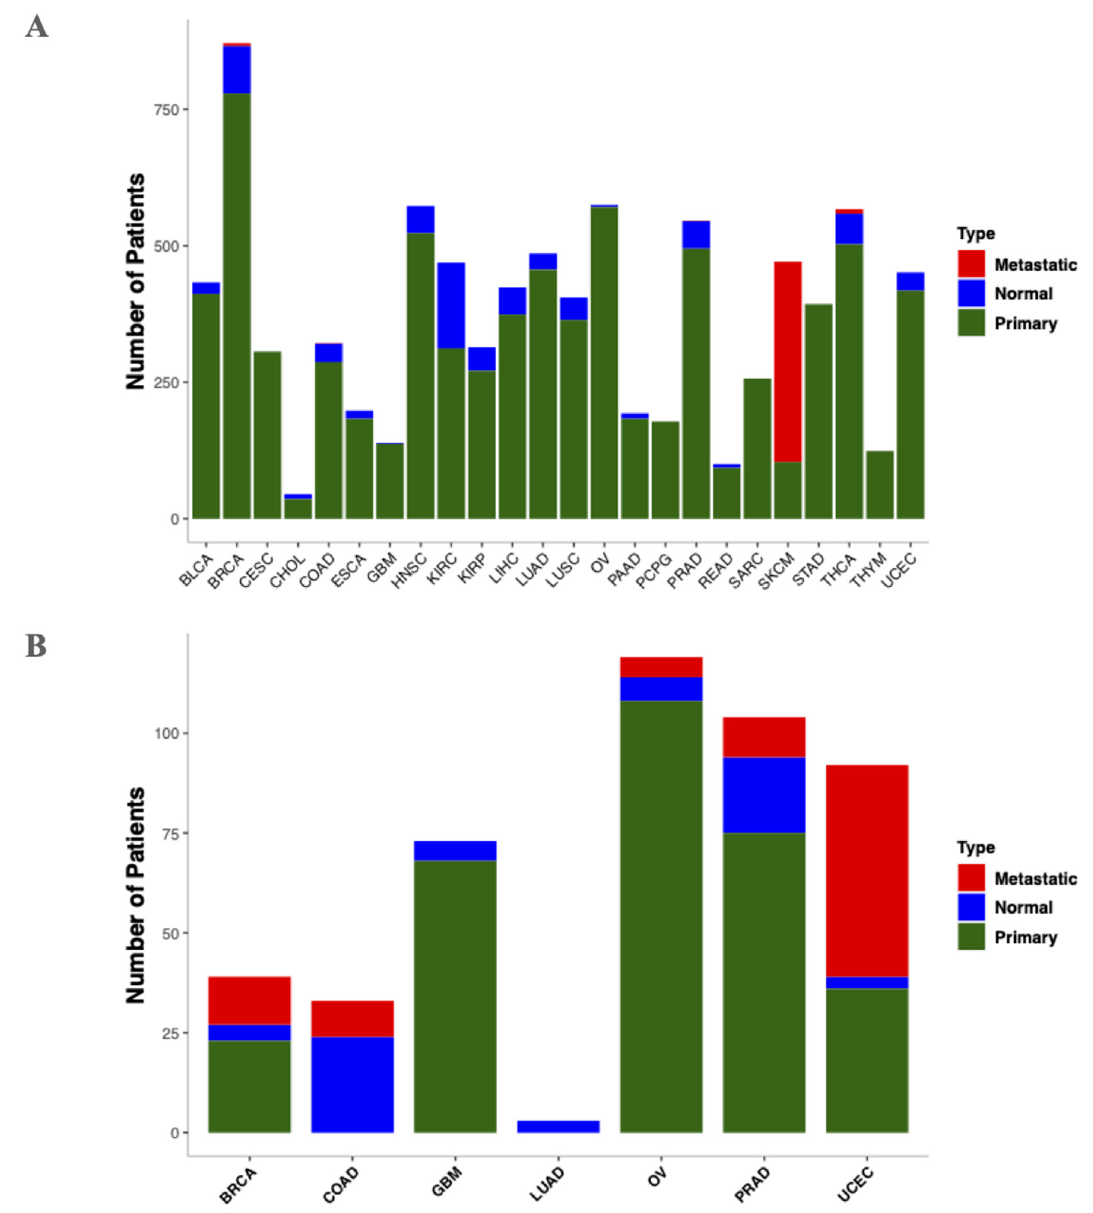
Figure 1. Bar plot for depicting the number of methylome samples used in this study. ( A ) Samples from TCGA. ( B ) Samples from GEO. Blue color bars indicate normal samples, while green and red denote primary and metastatic tumors, respectively. BLCA: bladder urothelial carcinoma; BRCA: breast invasive carcinoma; CESC: cervical squamous cell carcinoma and endocervical adenocarcinoma; CHOL: cholangiocarcinoma; COAD: colon adenocarcinoma; ESCA: esophageal carcinoma; GBM: glioblastoma multiforme; HNSC: head and neck squamous cell carcinoma; KIRC: kidney renal clear cell carcinoma; KIRP: kidney renal papillary cell carcinoma; LIHC: liver hepatocellular carcinoma; LUAD: lung adenocarcinoma; LUSC: lung squamous cell carcinoma; OV: ovarian cancer; PAAD: pancreatic adenocarcinoma; PCPG: pheochromocytoma and paraganglioma; PRAD: prostate adenocarcinoma; READ: rectum adenocarcinoma; SARC: sarcoma; SKCM: skin cutaneous melanoma; STAD: stomach adenocarcinoma; THCA: thyroid carcinoma; THYM: thymoma; UCEC: uterine corpus endometrial carcinoma.